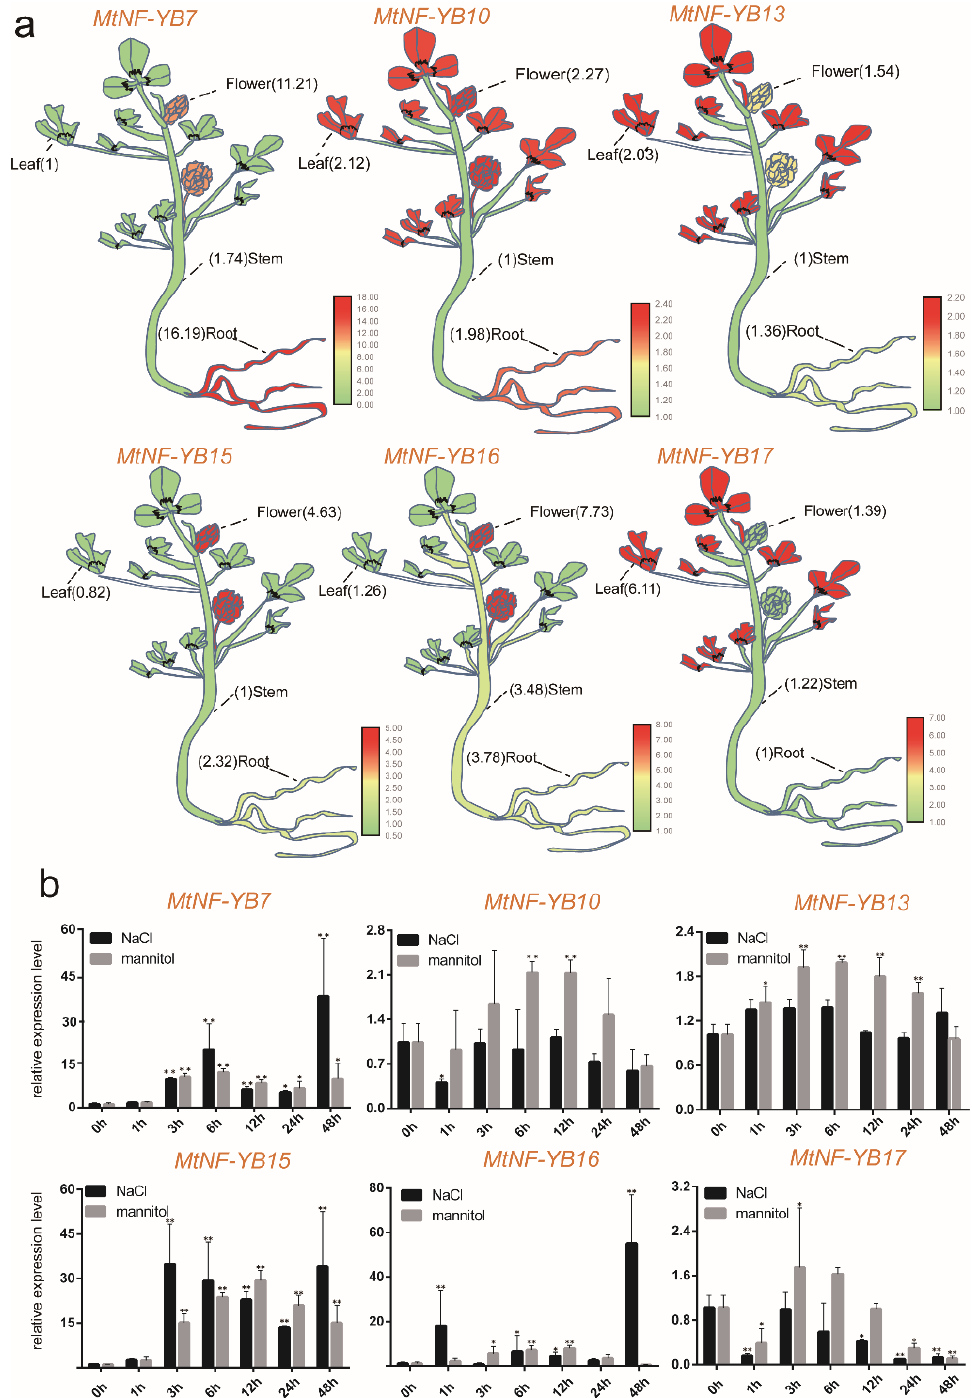
Figure 8. Quantification of gene expression levels of selected NF-YB genes from M. truncatula using RT-qPCR. ( a ) Expression level of MtNF-YB genes in different tissues. ( b ) Expression level of MtNF-YB genes under NaCl and mannitol stress. Data are average of three independent biological samples ± SE, and vertical bars indicate standard deviation. ** indicates p < 0.01, and * indicates p < 0.05.